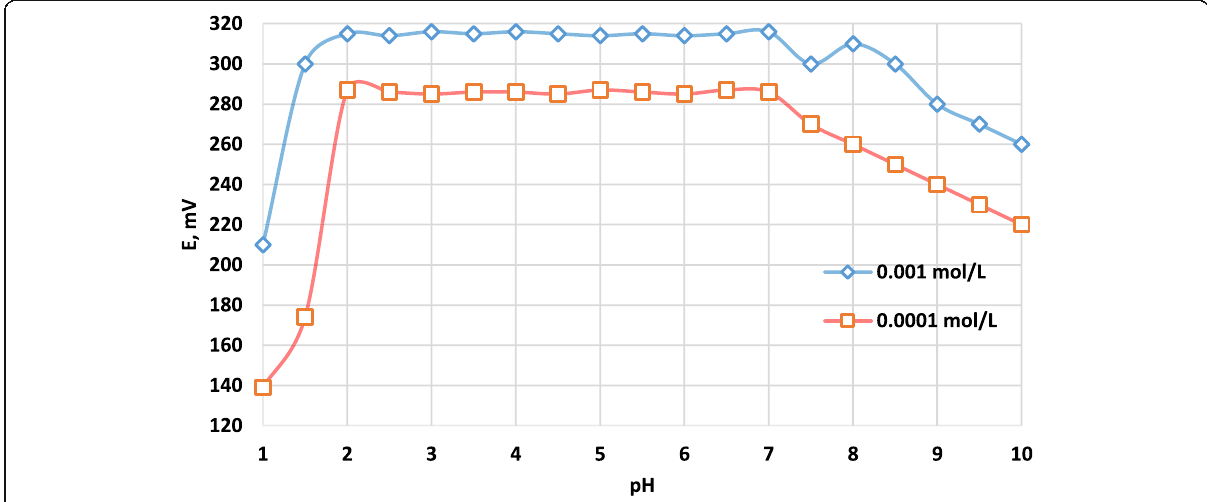
Fig. 3 Impact of pH on the response of Cd(II)-CPE